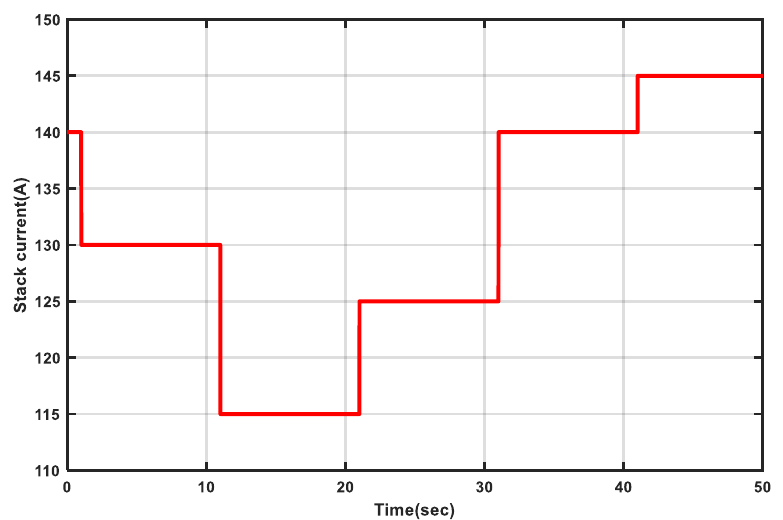
Figure A1. Stack current of PEMFC with Stochastic load condition.